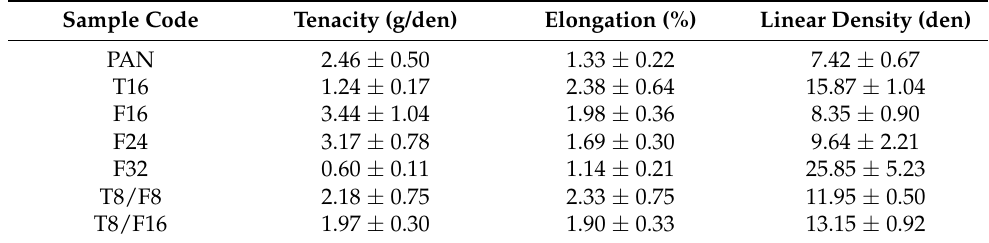
Figure 8. Load–elongation curve of the PAN-based composite yarn with different contents of carbon nanomaterials. Table 8. Mechanical properties of the PAN-based composite yarn with different contents of carbon